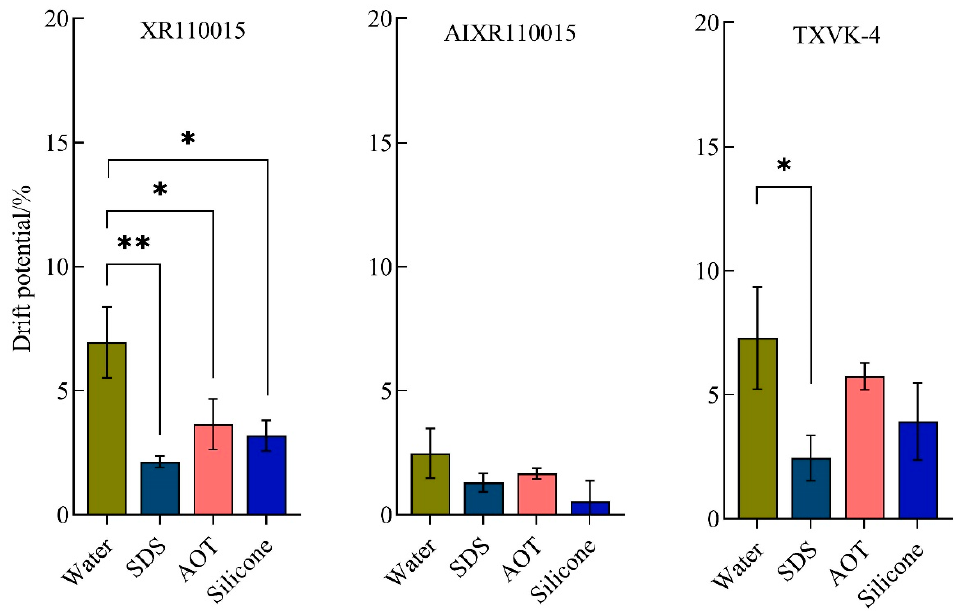
Figure 11. Drift potential percentages from polytetrafluoroethylene lines at the 2 m downwind position. “*” and “**” indicates significance at p ≤ 0.05 and p ≤ 0.01, respectively